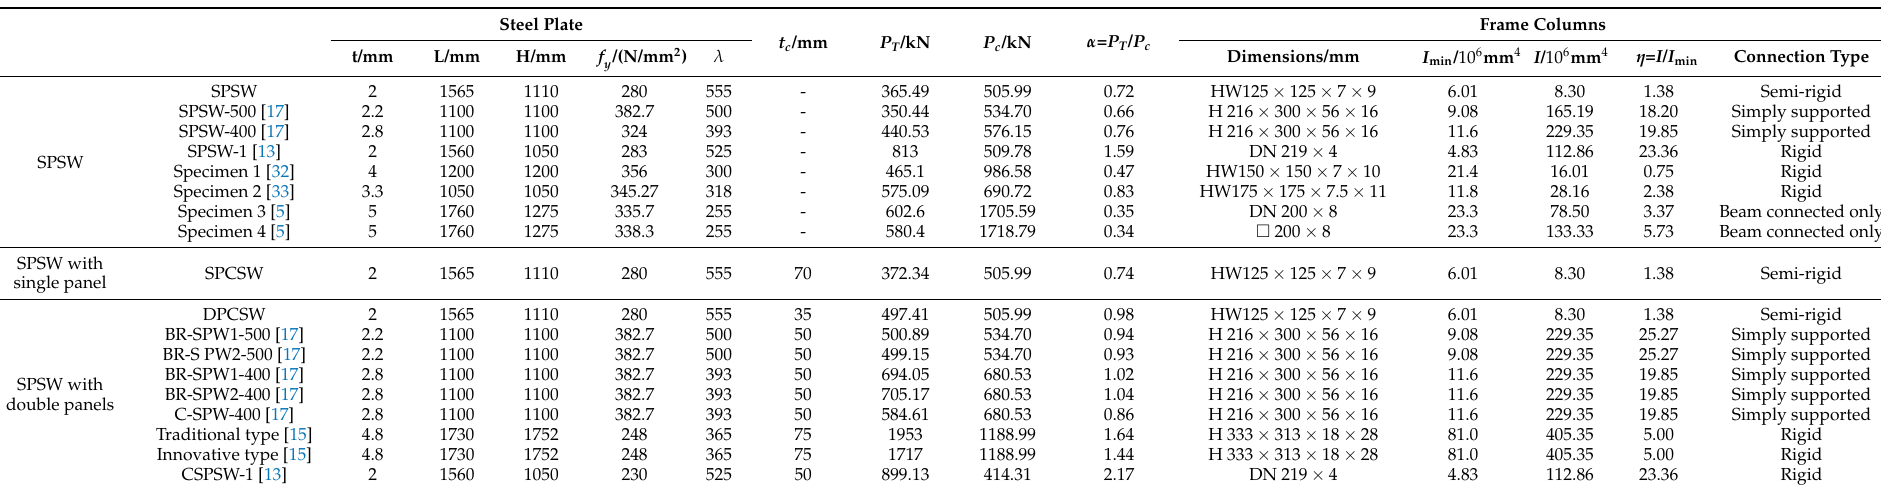
Table 4. Information of the tested